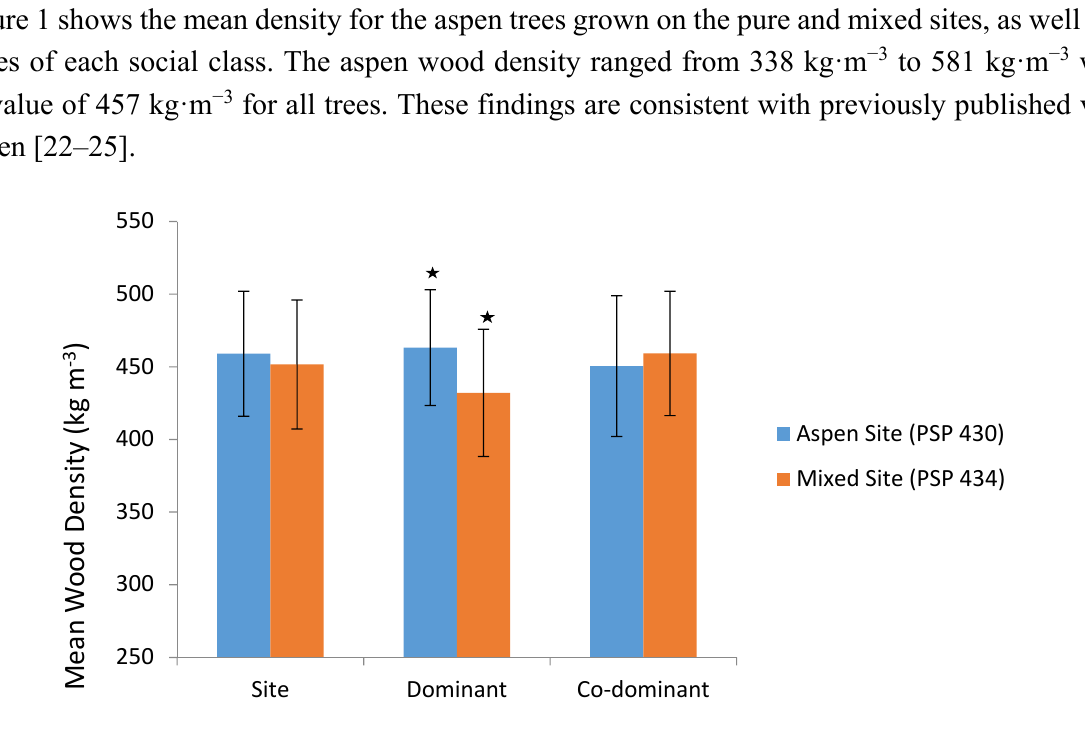
Figure 1. Mean wood density (kg·m − 3 ) for trembling aspen trees originating from an aspen site (PSP 430) and mixed site (PSP 434) by site and social classes. Error bars indicate standard deviation. Asterisk indicate significant differences ( α = 5%). n = 100 on the aspen site, while n = 50 on the mixed